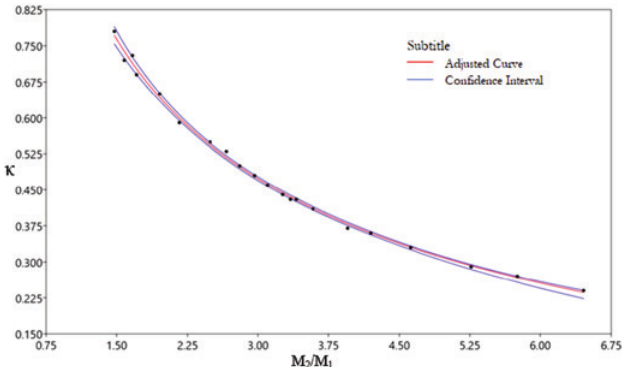
Figure 4 Adjustment between M interval of